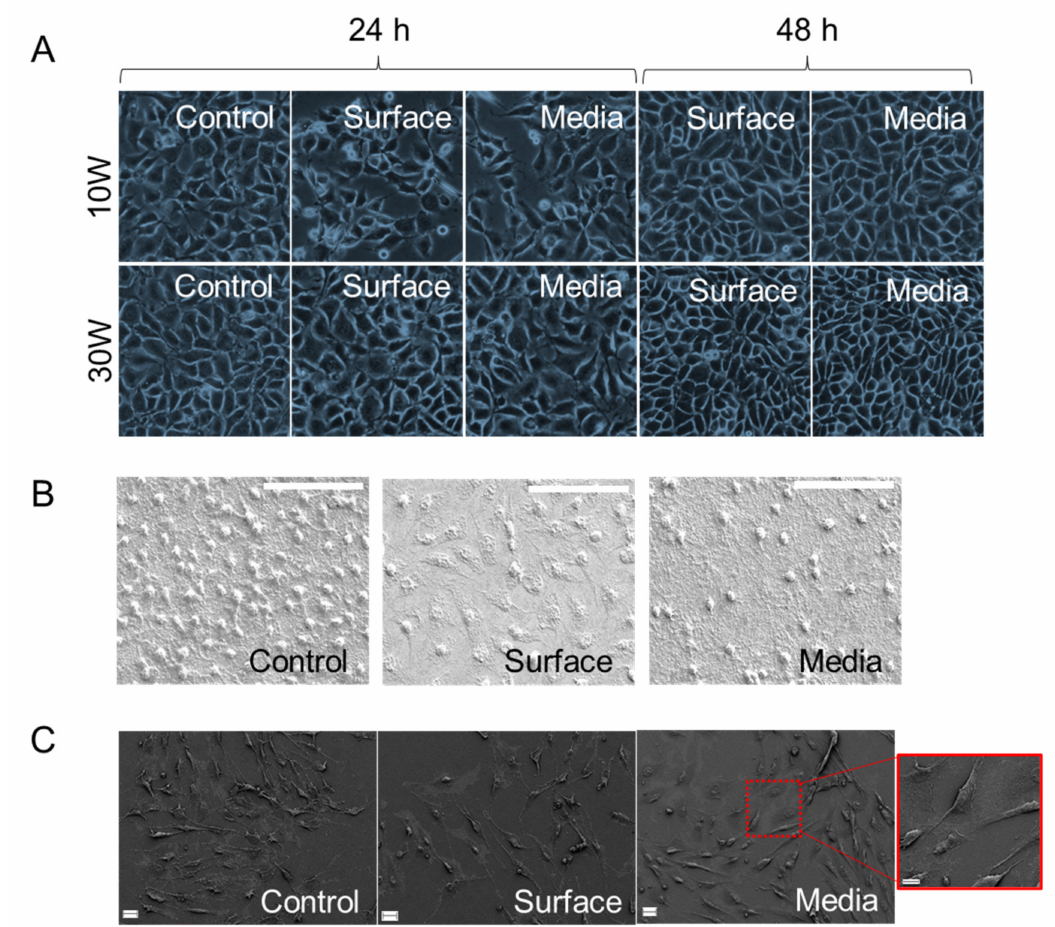
Figure 5. ( A ) Phase contrast images of wells containing fibroblasts grown in the presence of the coatings after 24 h and 48 h of incubation, scale bar 100 µ m, and ( B ) SEM images of fibroblasts attached on the surfaces of substrata after 48 h of incubation, scale bar 50 µ m. ( C ) SEM images of osteoblasts attached on the surfaces of substrata after 48 h of incubation, scale bar 20 µ m, scale bar for inset 10 µ m. For all images: “Control” denotes as-deposited surface and standard media, “Surface” is plasma treated surface and standard media, “Media” is as-deposited sample and plasma treated media. Data shown for polymer coatings fabricated at 10